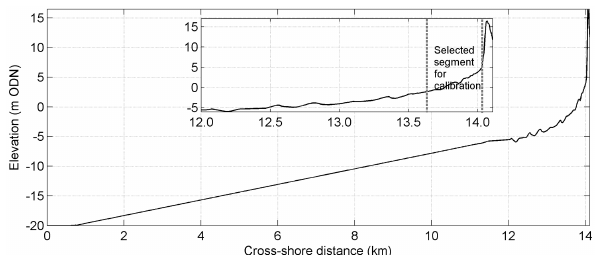
Figure 3. The pre-storm 1-D profile based on the observed data from survey location P14 (see Fig. 1). Calibration was performed over the transect length available from the post-storm